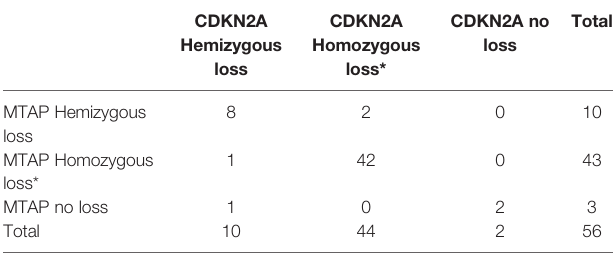
TABLE 4B | Comparison of fl uorescence in situ hybridization (FISH) results for detecting methylthioadenosine phosphorylase (MTAP) and CDKN2A deletion in malignant pleural mesothelioma (MPM)